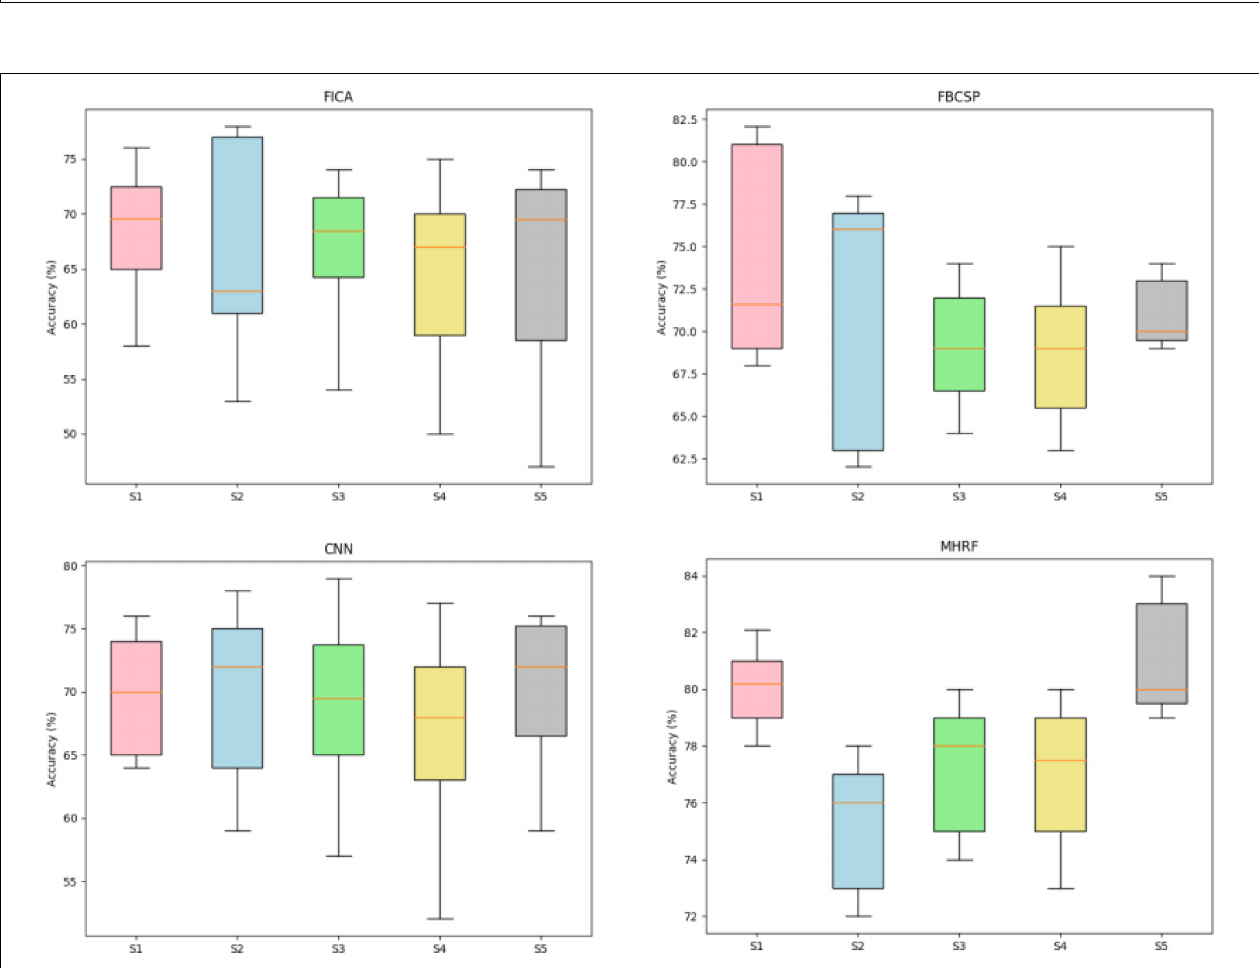
FIGURE 6 | The inter-session transfer accuracies applied to five subjects (S1-S5) with four algorithms (FICA, FBCSP, CNN, and MHRF). The brown line Brown lines indicate the median values and the upper and lower edges of the box indicate the quartiles.